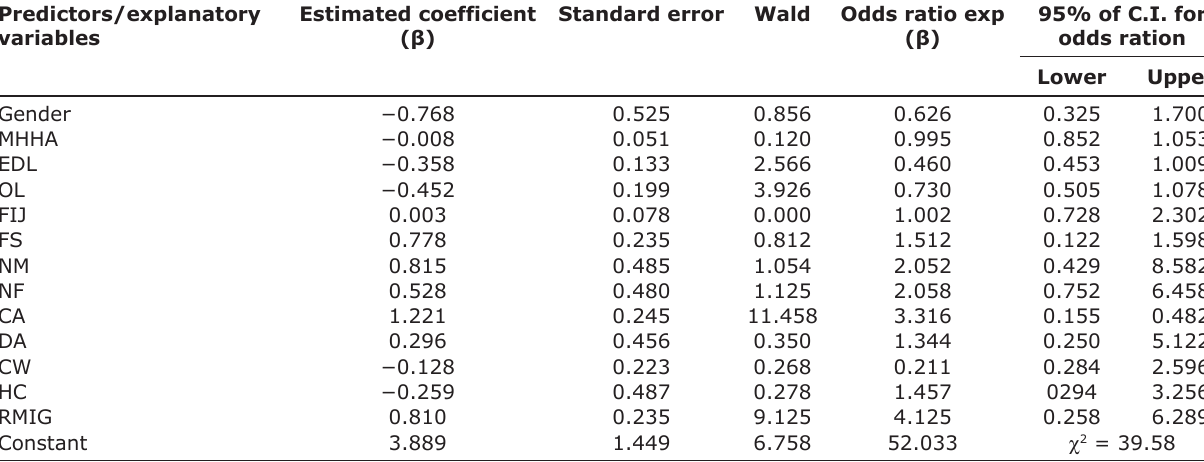
Table-3: Model of risk factors causing urban